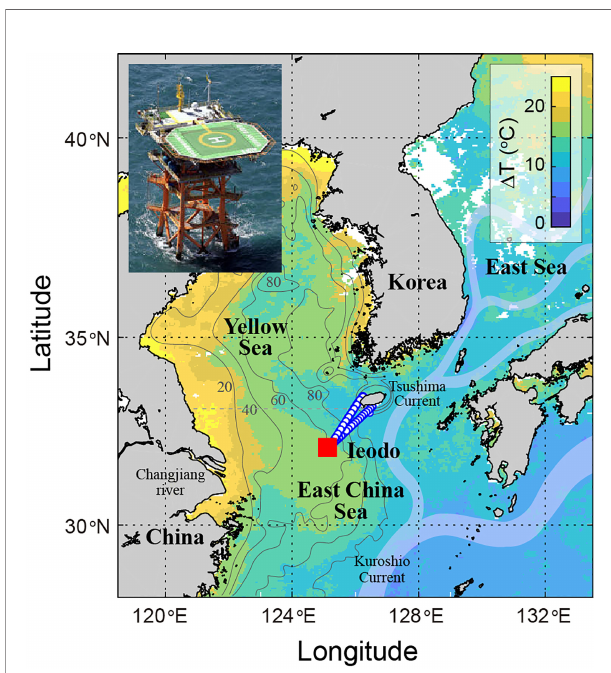
FIGURE 1 | Sampling locations for continuous pH measurements (red square: the Ieodo Ocean Research Station) and for discrete measurements of C parameters between Jeju Island and Ieodo (blue circles). Colors indicate the seasonal temperature extremes (August values minus February values) for 2020. Arrows indicate the path of the Kuroshio Current with its branch (Tsushima warm current) into the East Sea. The contour lines indicate the bathymetry